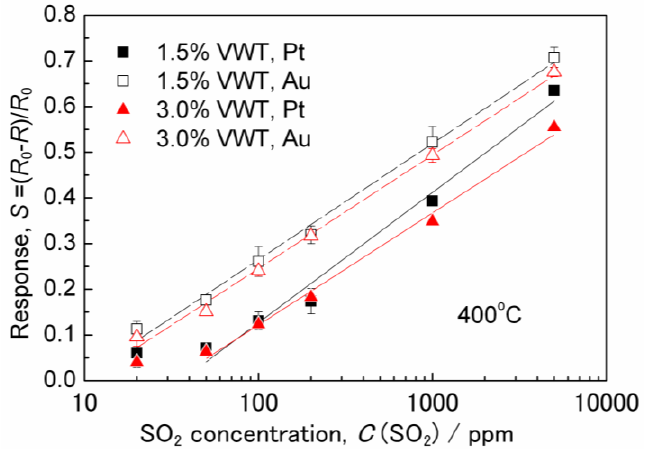
Figure 2. Relationship between the response value, S , of the sensor resistance and the SO concentration at T = 400